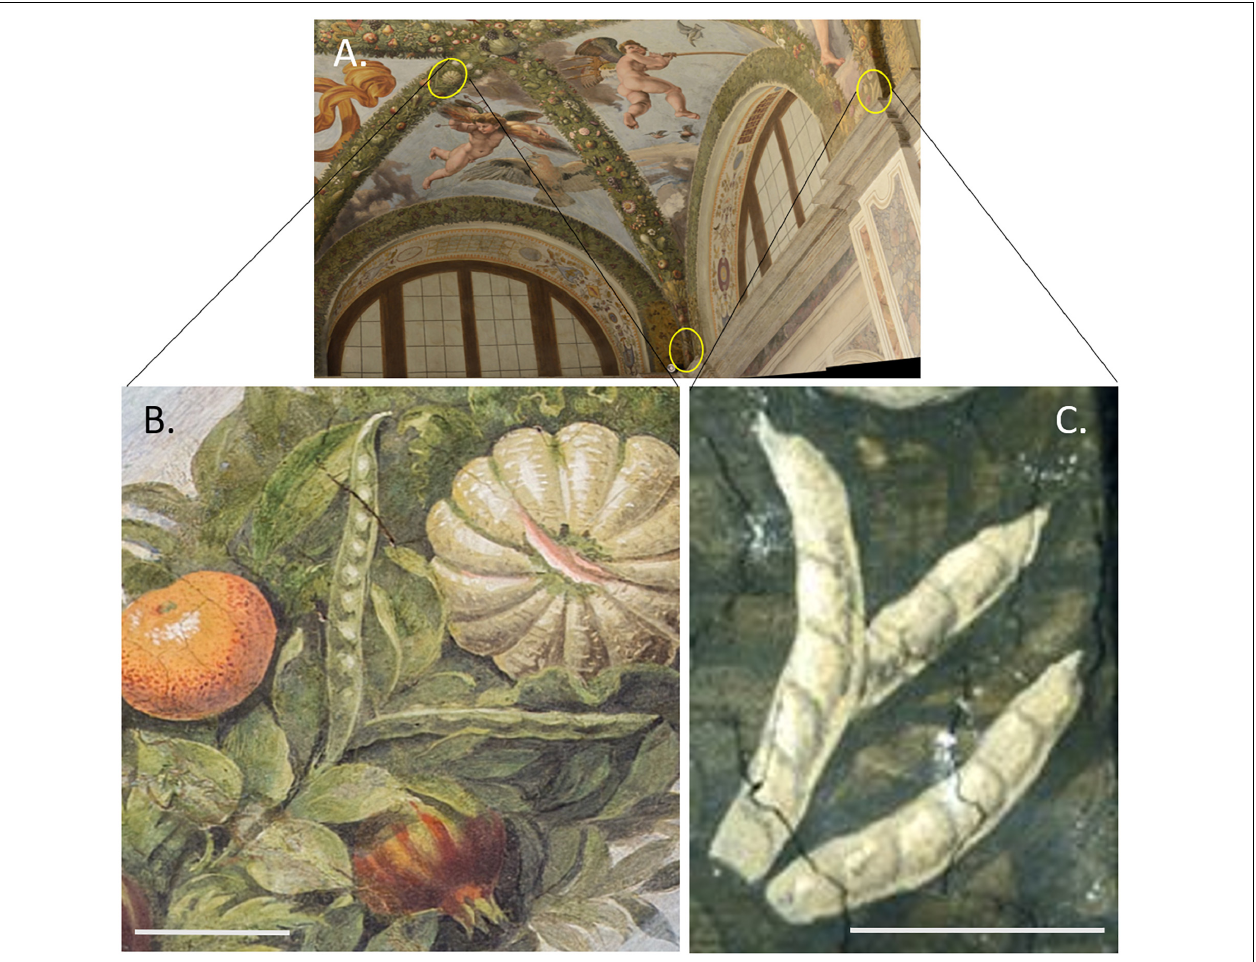
FIGURE 2 | Overview of the Loggia of Cupid and Psyche in the Villa Farnesina and close up of legume pods. (A) View to the northwest with the location of putative common bean pods indicated by yellow circles in the festoons. Source: Sgamelotti and Caneva (2017). (B) Pods subtending a melon near the fresco depicting Cupid with the aspects of Jupiter. Source: J. Janick. (C) Pods located at the Foot of the Three Graces. Size bars = 10 cm. Source: J. Janick.